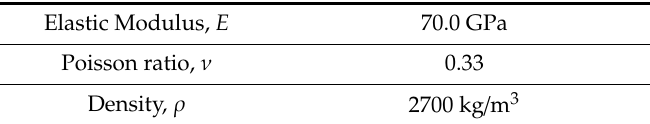
Table 1. Properties of aluminum alloy.